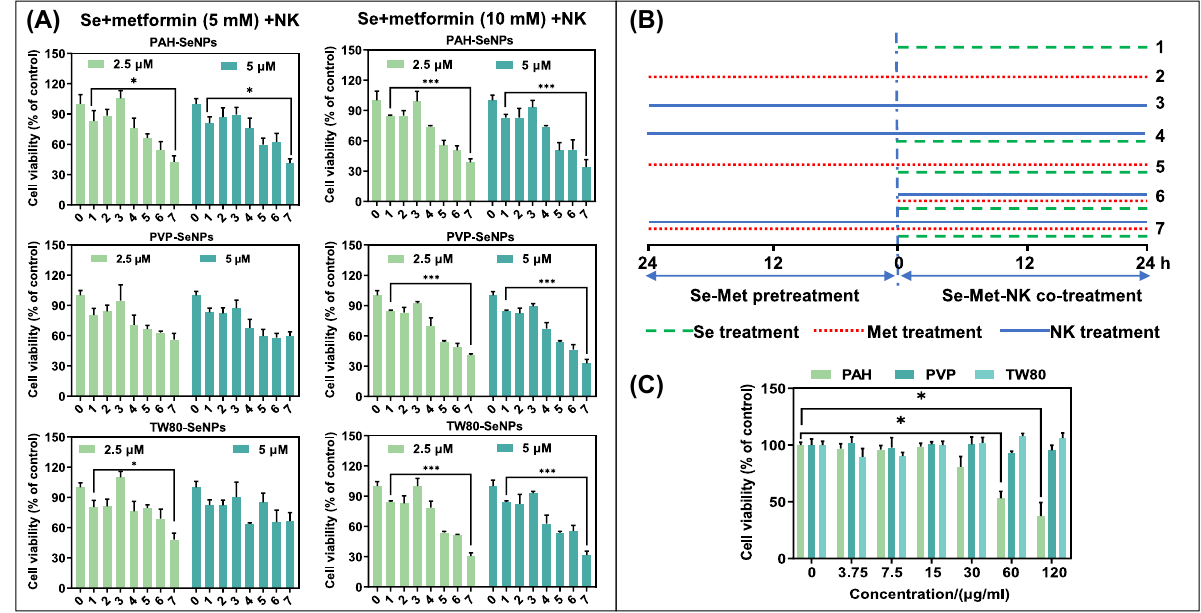
Figure 1: The cell viability of HepG2 cells after functionalized SeNPs combined with met and NK92 cells treatment. (A) The cell viability and (B) schematic diagram of different processing methods of the functionalized SeNPs combined with met and NK92 cells. (C) The cell viability of the polymer PAH, PVP and TW80 for HepG2 cells. Each value represents means ± SD ( n = 3), ∗ p ≤ 0.05, ∗∗ p ≤ 0.01, ∗∗∗ p ≤